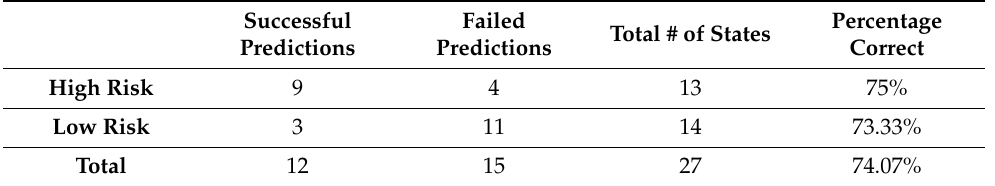
Table 9. Classification table for logistic model results.